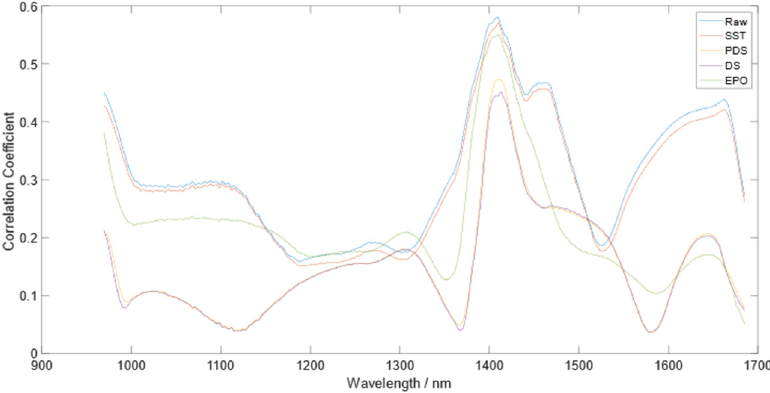
Figure 8. The correlation coefficient between the soil spectra and the TN content in all wavelengths.